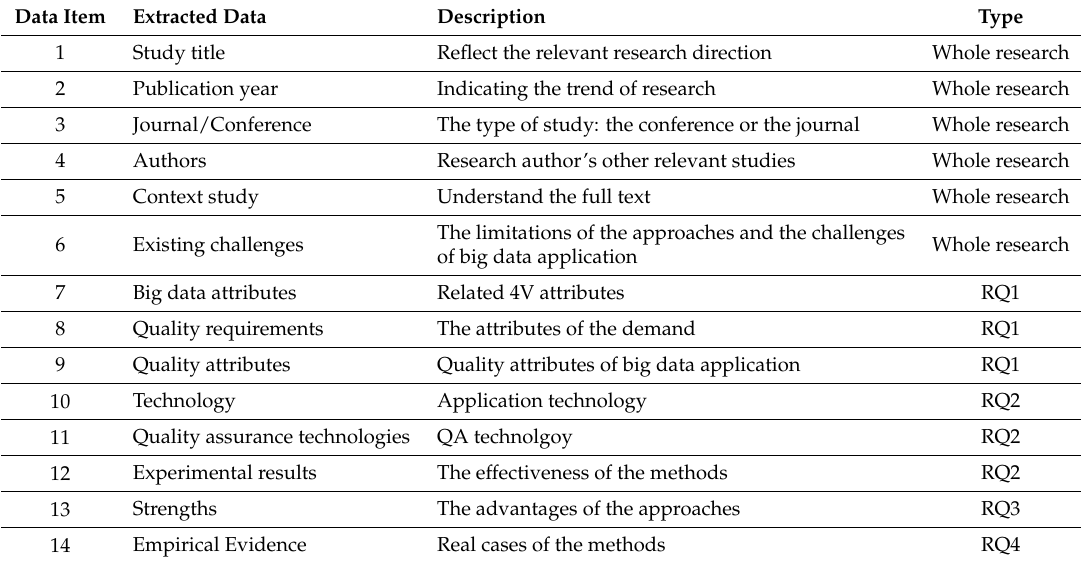
Table 7. Data extraction